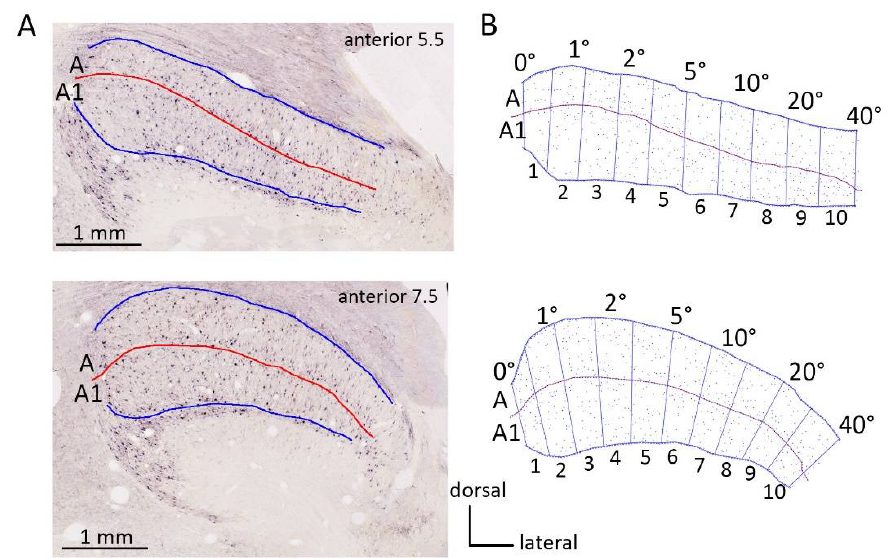
Figure 1. The method for obtaining the image of the LGN section: ( A ) drawing of the layer A and A1 borders with the positions of the SMI-32 immunopositive neurons marked; ( B ) dividing the LGN layers into 10 sectors.